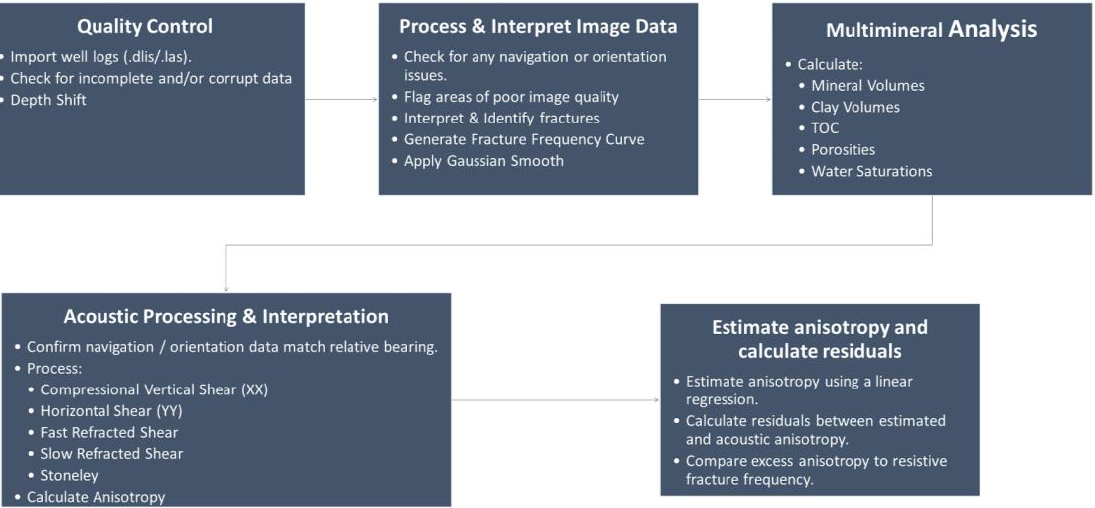
Figure 6. Suggested workflow for fracture frequency prediction starting with quality control of well logs, processing, interpretation and evaluation of data, followed by the linear estimation of anisotropy and calculation of residuals.